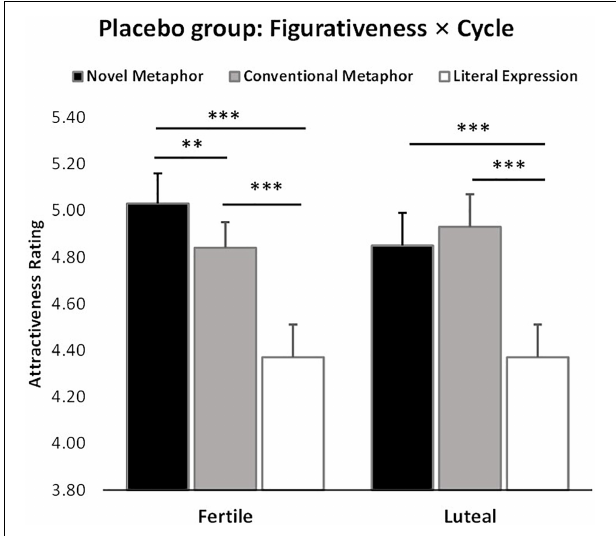
FIGURE 4 | Cycle × figurativeness interaction effect on attractiveness ratings independent of treatment ( n = 62). ∗∗ p < 0.01, ∗∗∗ p < 0.001, two-tailed t- test. Bars indicate M ±